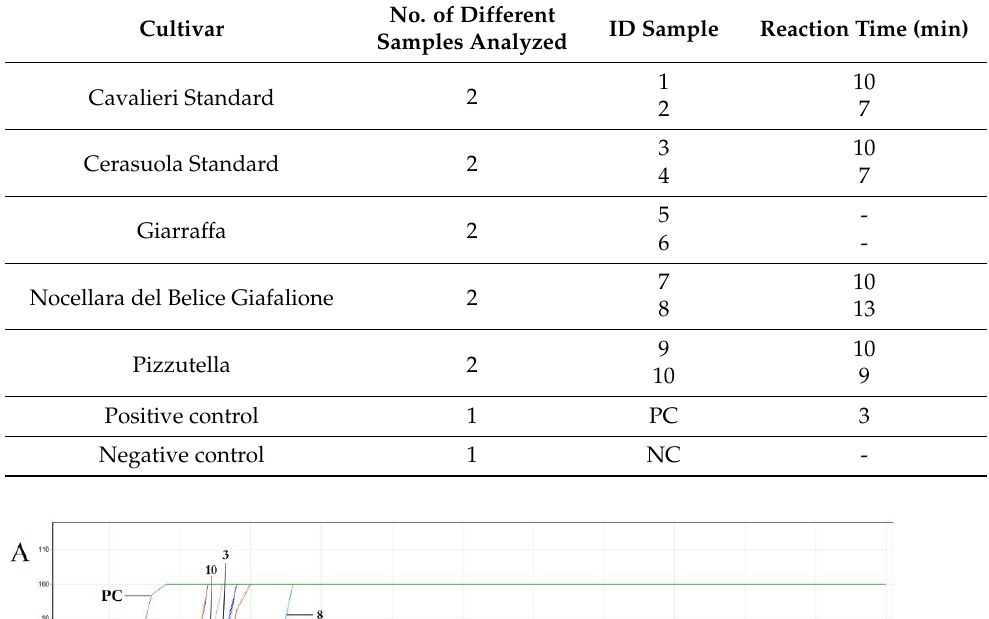
Table 3. Performance of the real time LAMP assay for the detection of OEGV in olive samples collected in Sicily.